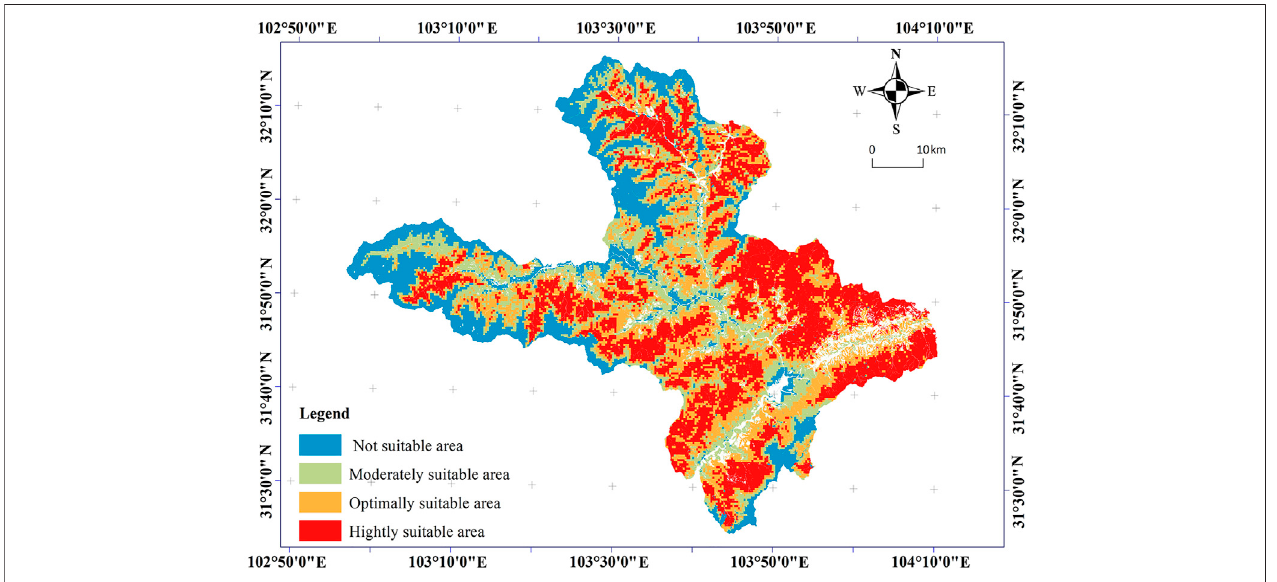
FIGURE 7 | Overlapping distribution of suitable areas of four tree